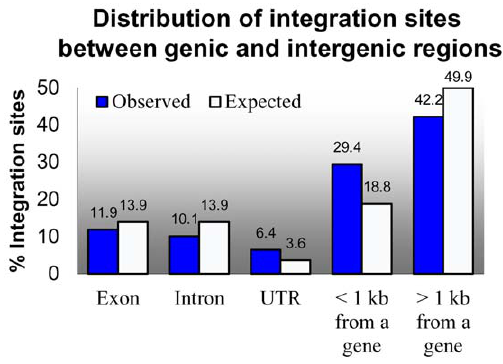
Figure 6. Distribution of insertion sites between genic and intergenic regions. A comparison of the observed and expected percentages of T-DNA insertions is illustrated for each insertion class. Insertions in UTRs and within 1 kb of a gene are observed to be substantially higher than expected. Intergenic insertions . 1 kb from a gene are lower than